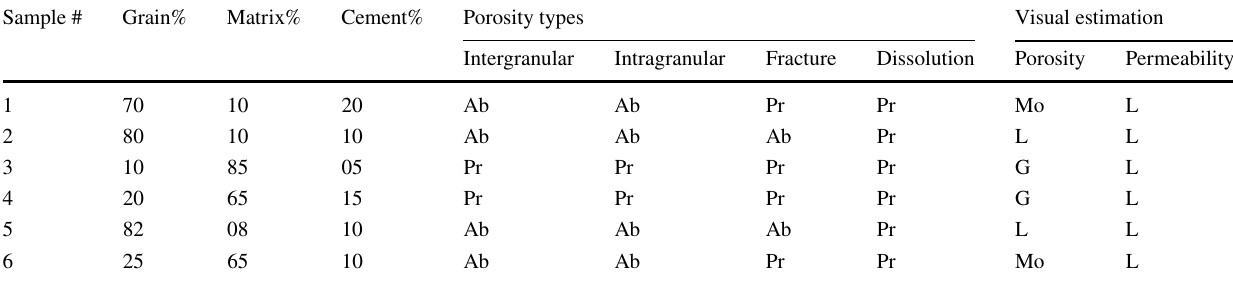
Pr present, Ab absent, L low, G good, Mo Table 3 Petrographic analysis of the Jurassic Samana Suk Formation